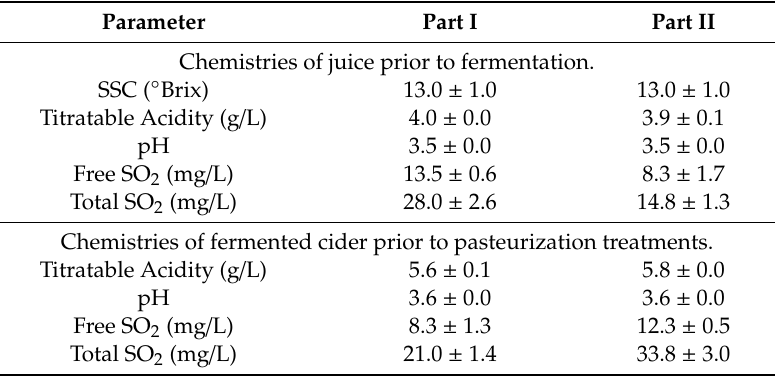
Table 1. Chemistries of juice and cider prior to pasteurization